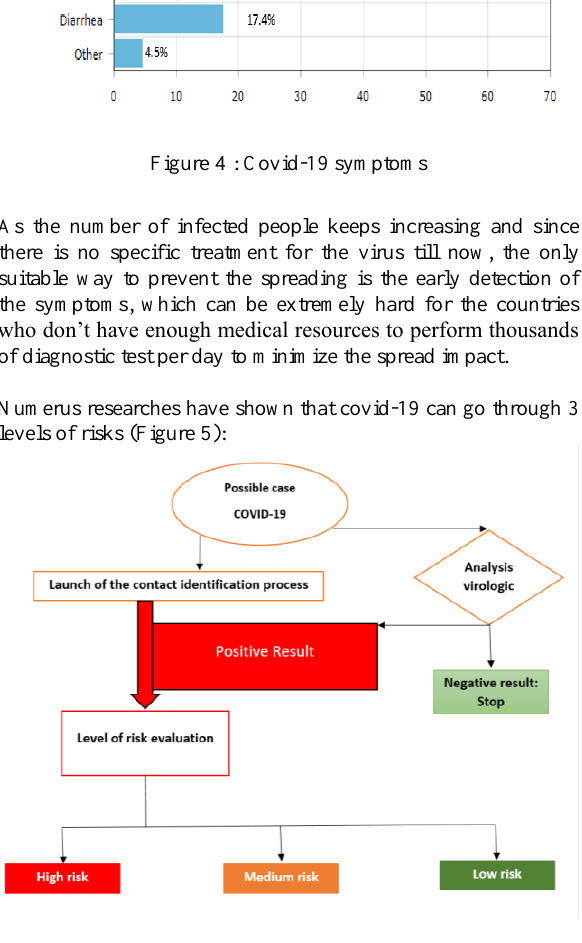
Figure 5 : Covid-19 three levels of risk